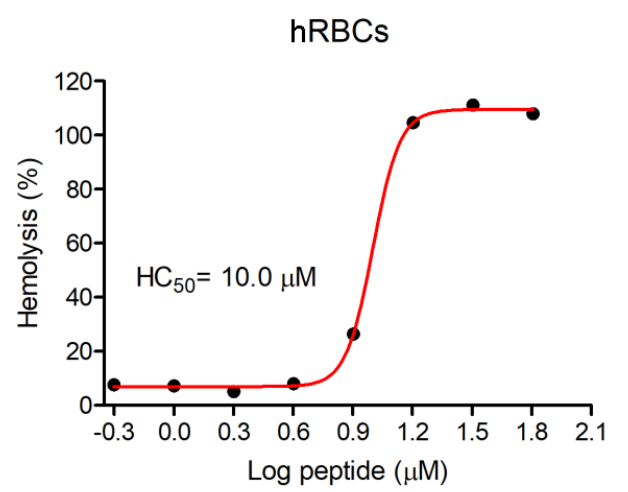
Figure 5. The hemolytic e ff ect of Figainin 1 on human erythrocytes (hRBCs).